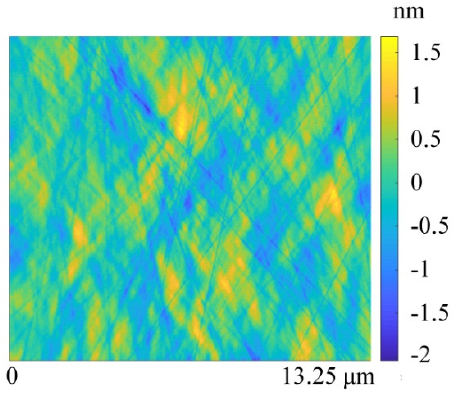
Figure 14. Simulated surface morphology for monocrystalline silicon with pure colloidal silica slurry within a 13.25 µ m × 13.25 µ m range for sufficient polishing iterations; the sampling points are 500 × 500 in the x–y direction.